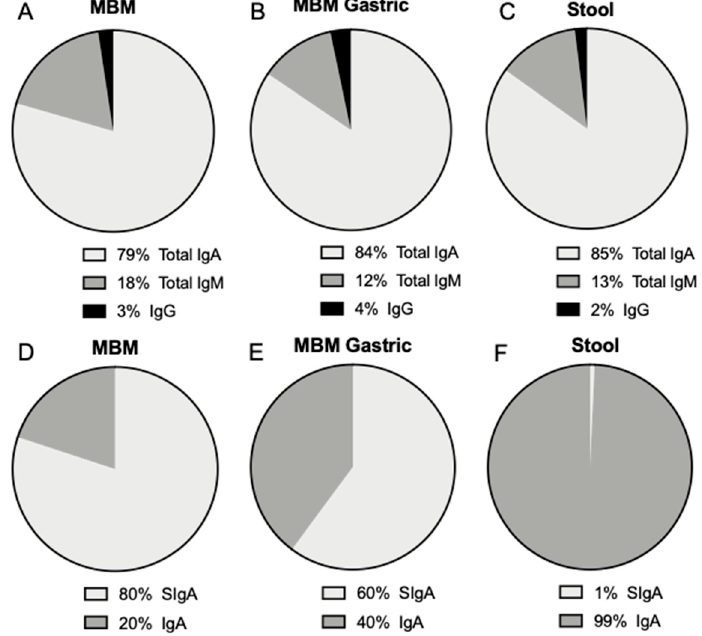
Figure 3. Proportion of total IgA, total IgM and IgG ( A ) in mother’s own breast milk (MBM), ( B ) in gastric contents at 1-hour postprandial time from preterm infants fed MBM and ( C ) in infant stools (from MBM, DBM and/or infant self). Proportion of SIgA and IgA from total IgA ( D ) in mother’s own breast milk (MBM), (E) in gastric contents at 1-hour postprandial time from preterm infants fed MBM and ( F ) in infant stools. Values are mean, n = 36 for MBM ( n = 20 for 8–9 days and n = 16 for 21–22 days of postnatal age).